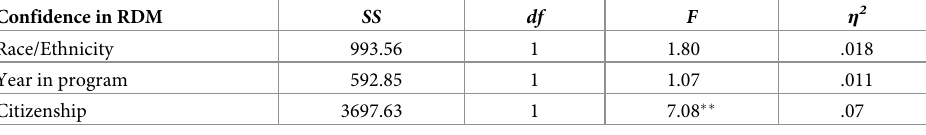
Table 3. RDM confidence by race/ethnicity, years in the program, and citizenship.